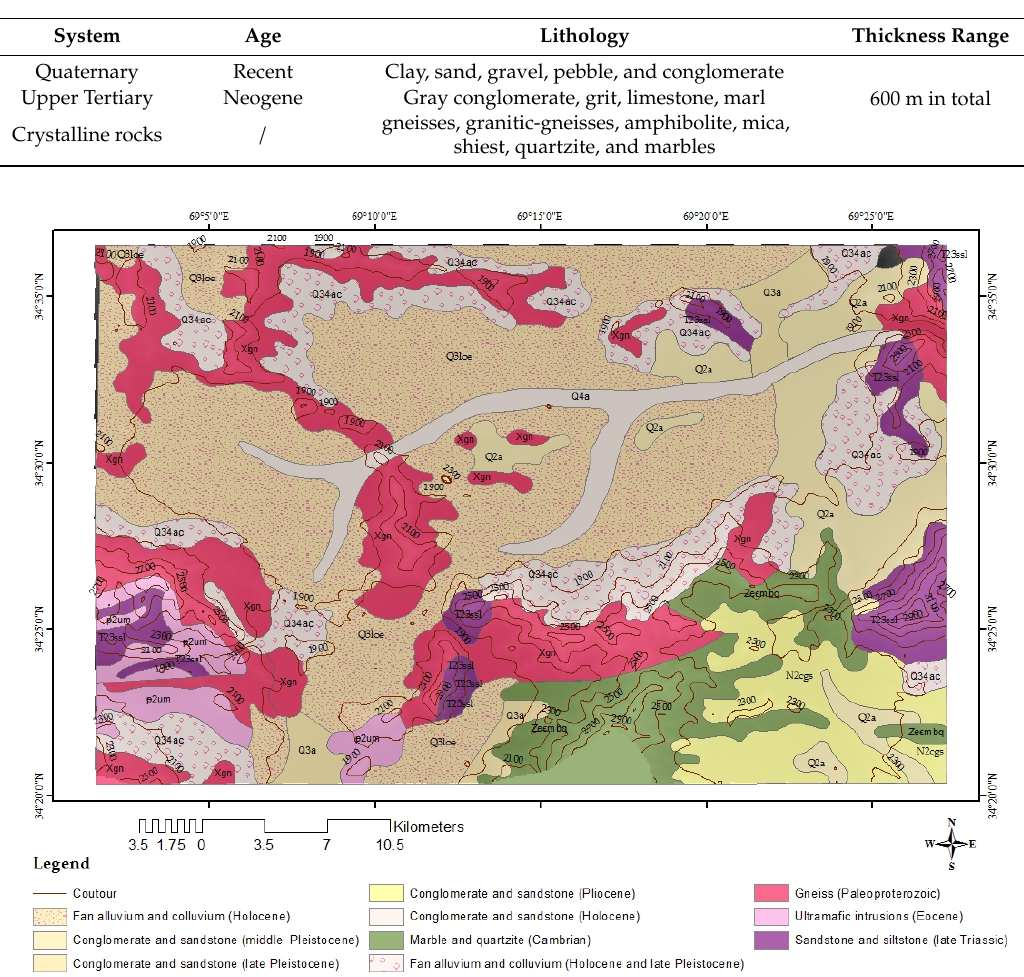
Table 1. Geological Condition of the Kabul Basin [16,20] .